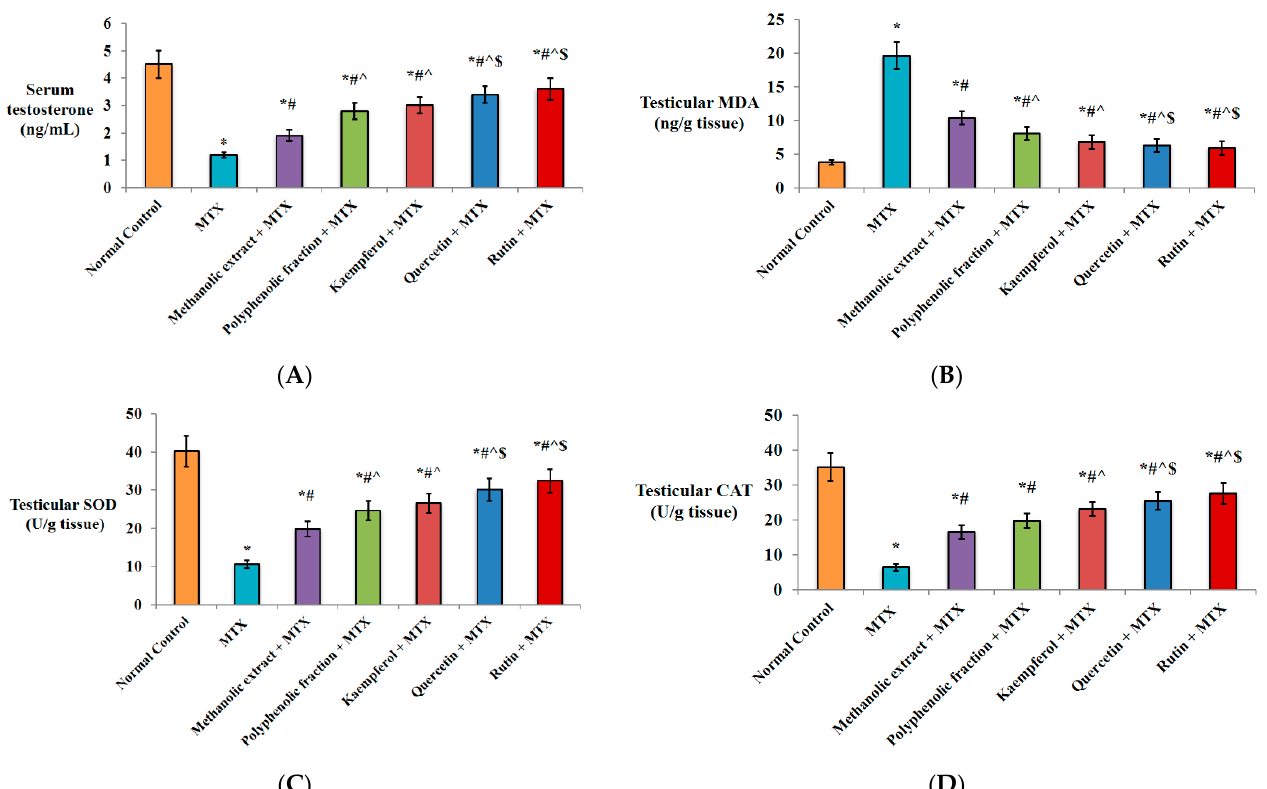
Figure 1. Effect of M. alysson L. methanolic extract, its polyphenolic fraction, kaempferol, quercetin and rutin on testicular injury-induced mice. ( A ) Serum testosterone, ( B ) Testicular MDA, ( C ) Testicular SOD level and ( D ) Testicular CAT level. Data are presented as mean ± SD, (n = 8). * Significant versus normal control. # Significant versus MTX. ^ Significant versus methanolic extract. $ Significant versus polyphenolic fraction. p value ≤ 0.01.